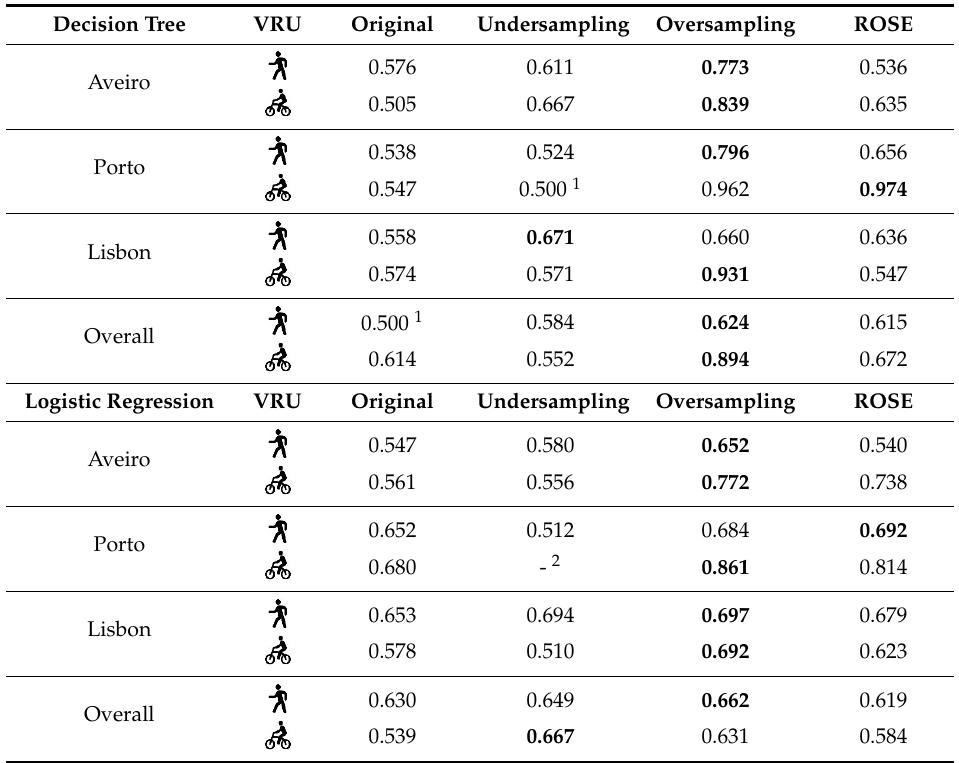
Table 2. Number of injuries and severity distribution for the different datasets. Key: represents pedestrians; represents cyclists.